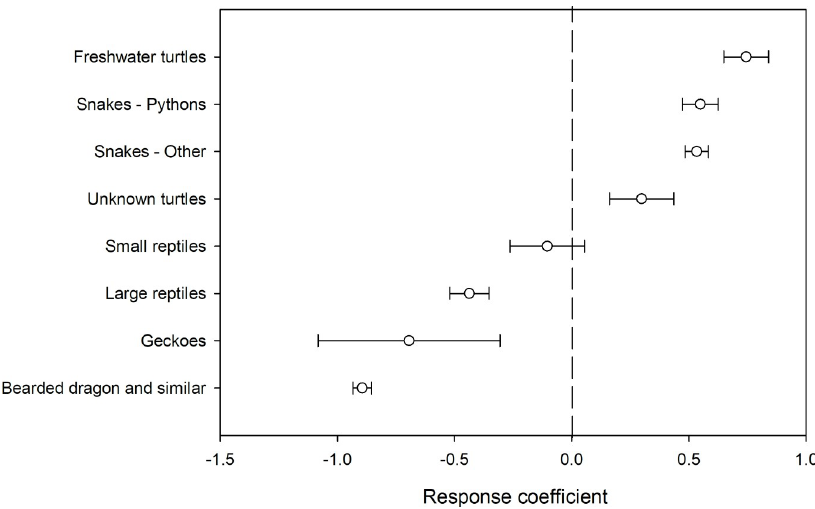
Fig 14. Response coefficient (+ - 95% CI) of reptile subgroups indicating their relative positive or negative response amongst each other.